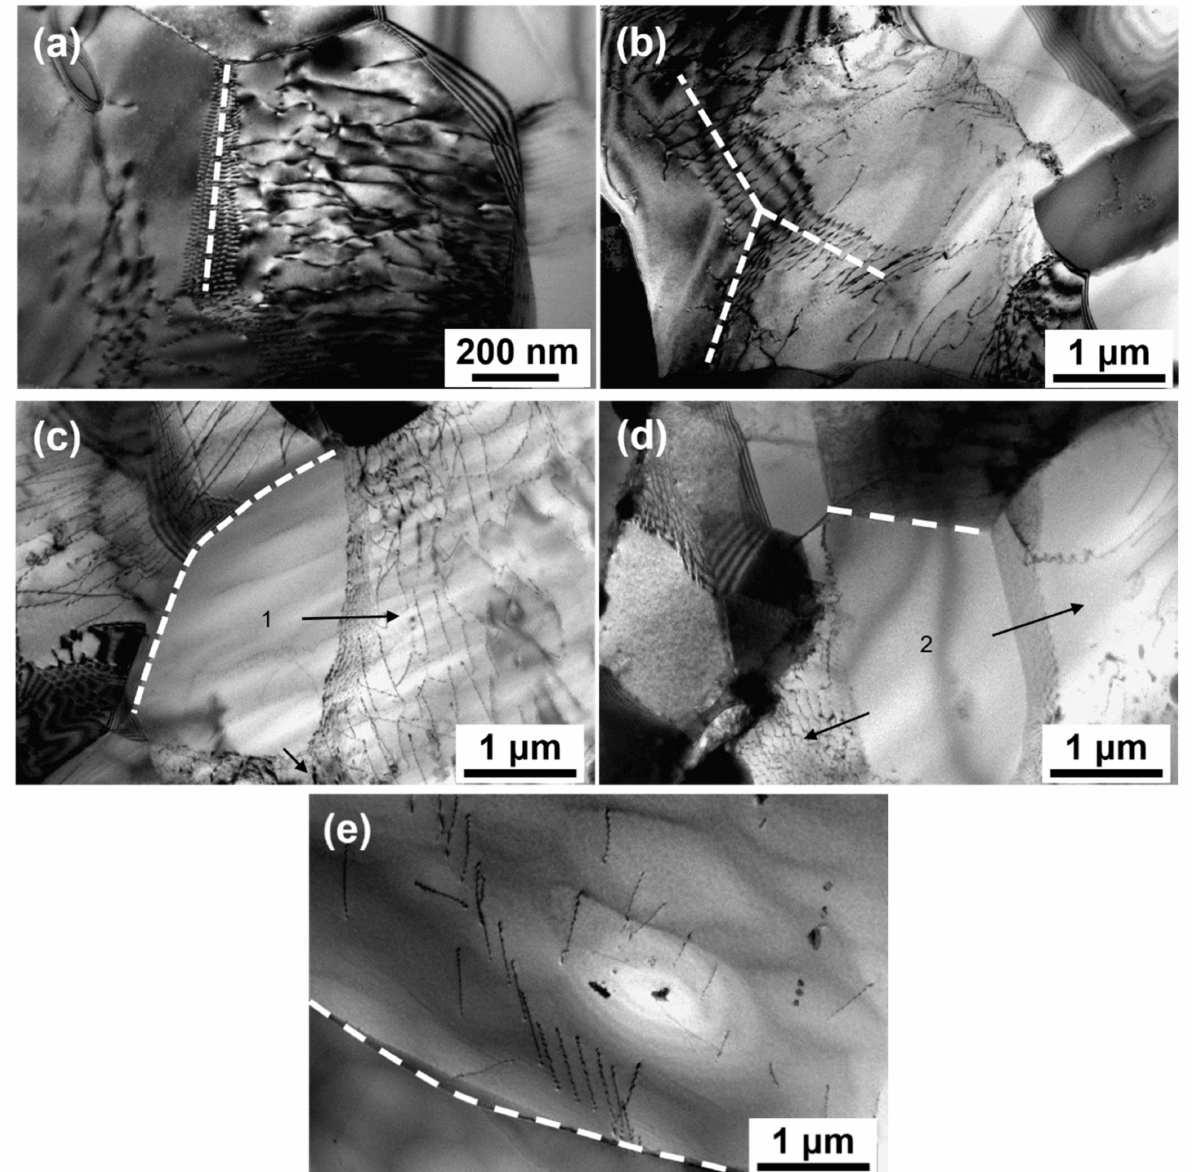
Figure 8. TEM images of DRV microstructure of spray-deposited 7055 aluminum alloy un- der hot compression conditions of 300 ◦ C/5 s − 1 ( a ), 300 ◦ C/0.001 s − 1 ( b ), 400 ◦ C/0.1 s − 1 ( c